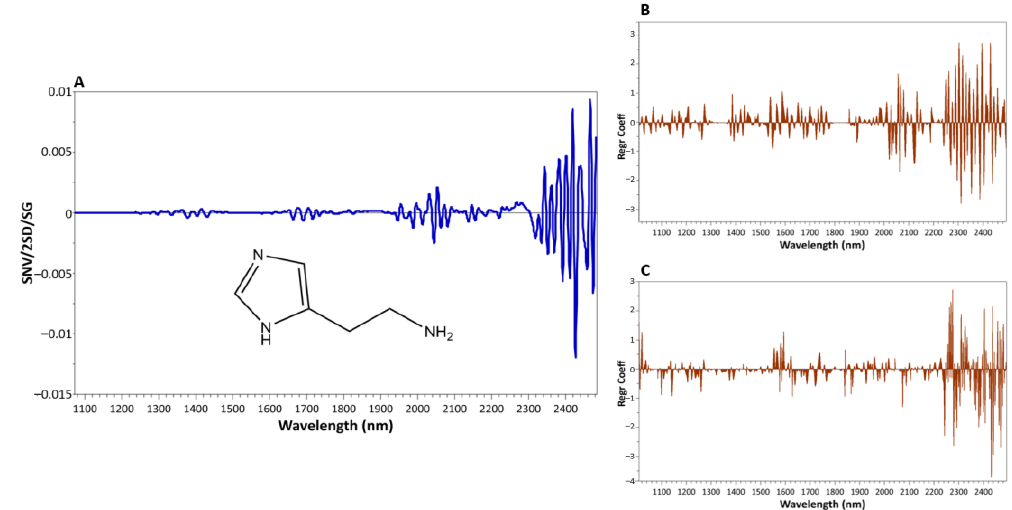
Figure 3. Mean processed spectrum (SNV + 2D + SG) plus chemical structure of pure histamine ( A ) and the prediction vector plots for histamine in raw ( B ) and processed tuna fish ( C ) regression models.